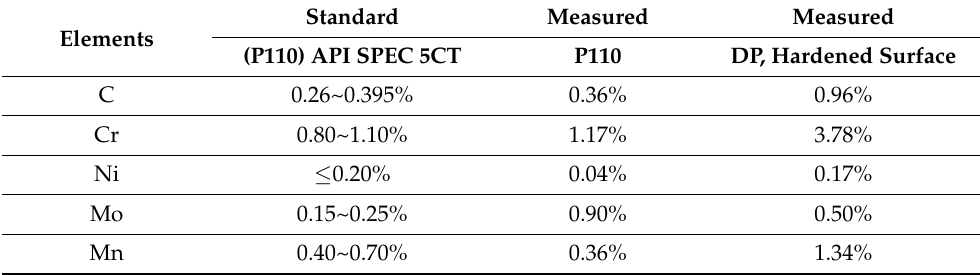
Table 1. Average elemental composition of casing material samples and the hardened facing of the drill pipe material.